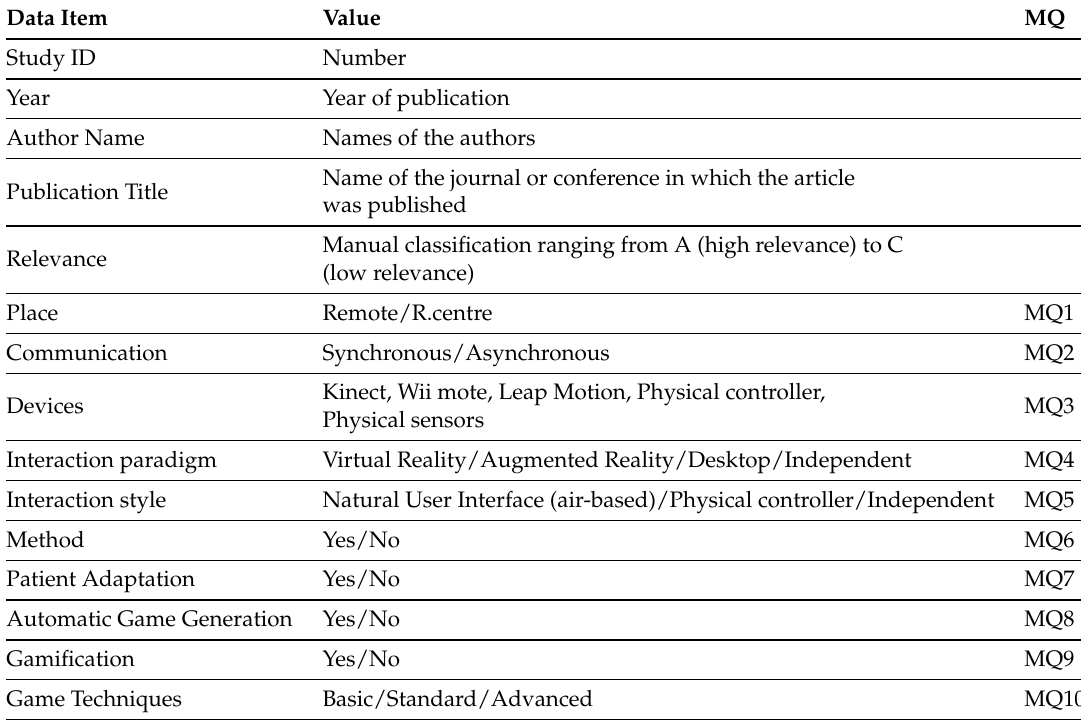
Table 4. Data extraction